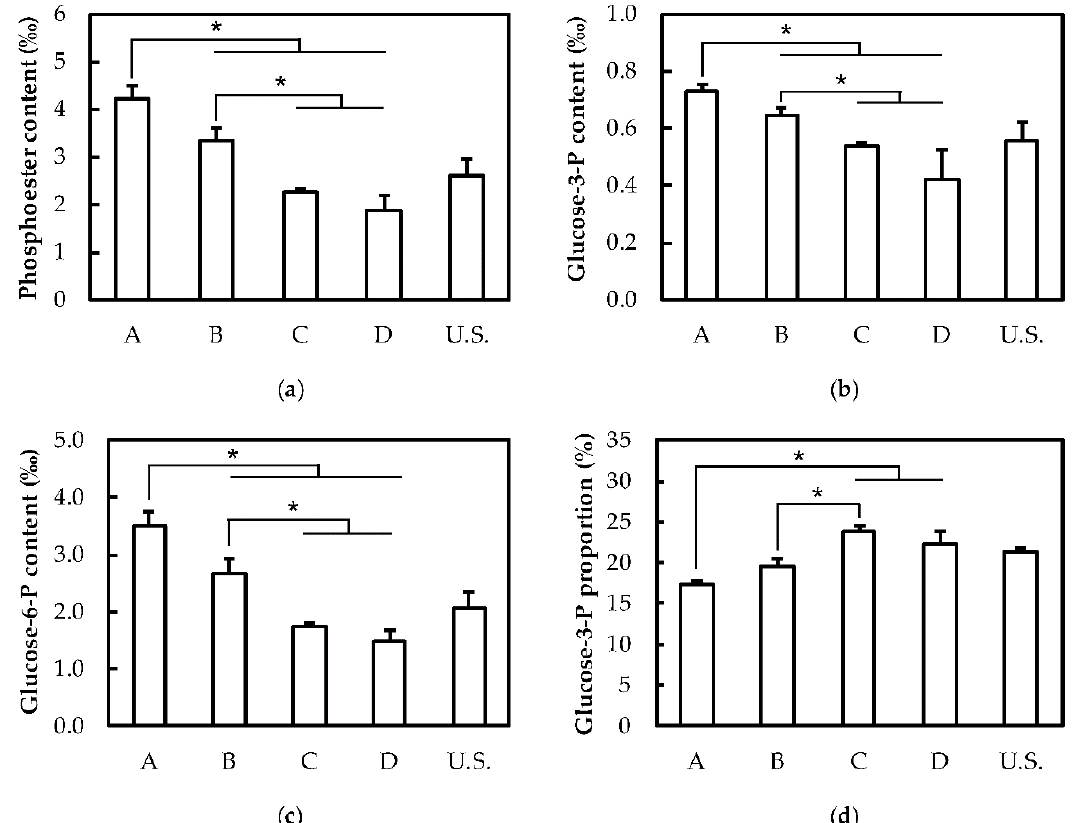
Figure 3. Phosphate contents. One milligram of starch from fractions A, B, C, and D and unfractionated starch (U.S.) was hydrolyzed prior to APTS-labelling and capillary electrophoresis analysis. ( a ) Total phosphate contents. ( b ) Glucose-3-P contents. ( c ) Glucose-6-P contents. ( d ) Proportion of glucose-3-P expressed in % of total phosphate. Error bars represent SDs calculated from three experimental replicates. The asterisks indicate significant differences according to one-way ANOVA with a P-value ≤ 0.01.